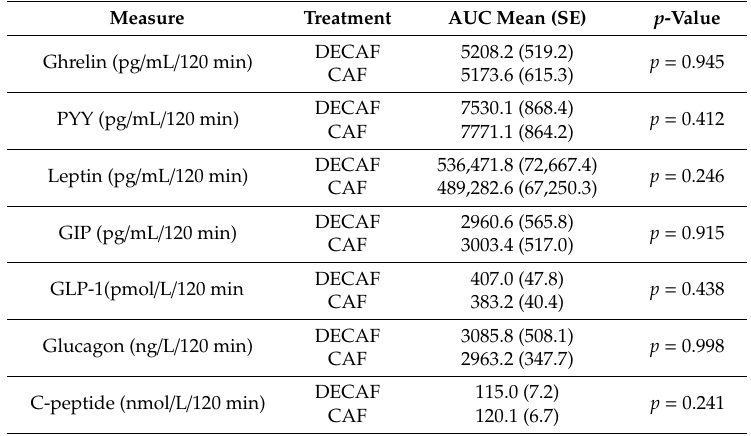
Table 3. Gut and metabolic hormones area under the curve (AUC) response to treatments.